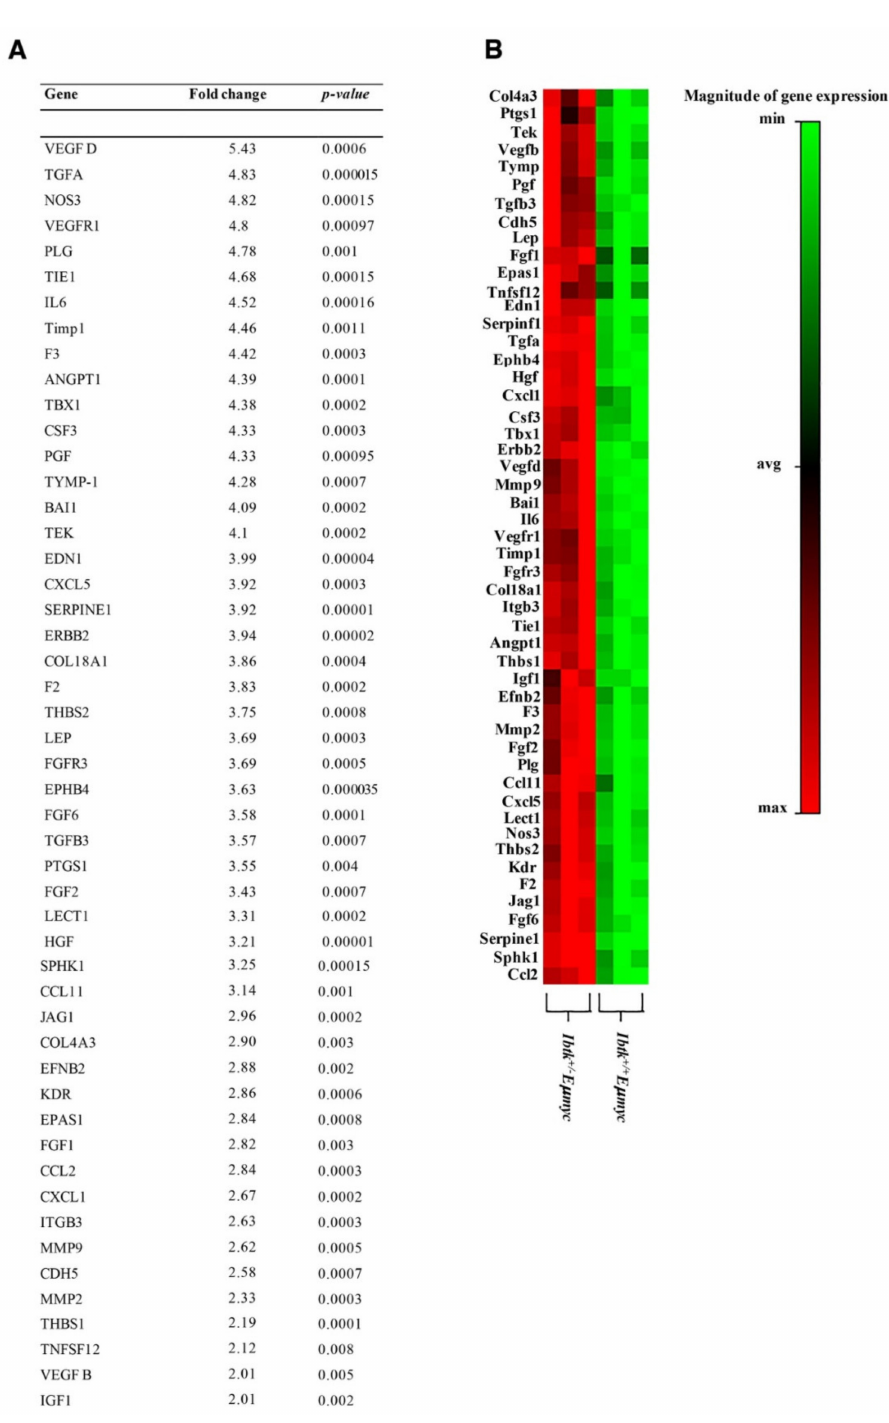
Figure 3. Increased expression of pro-angiogenic genes in the tumor lymph nodes of Ibtk +/ - E µ -myc mice. A. Total RNA was extracted from the tumor lymph nodes of Ibtk +/+ E µ -myc and Ibtk +/ - E µ -myc mice, and analyzed by quantitative real-time PCR using SABiosciences Angiogenesis RT 2 Profiler RT-PCR array. A di ff erence in gene expression was accepted at more than a 2-fold increase. Upregulated genes are indicated as the fold change of Ibtk +/ - E µ -myc relative to Ibtk +/+ E µ -myc mice. Data were analyzed by two-tailed unpaired Student’ t test ( p value < 0.05). B. Heat-map of the angiogenesis-related gene expression profile in Ibtk +/ − E µ -myc compared to Ibtk +/+ E µ -myc tumor